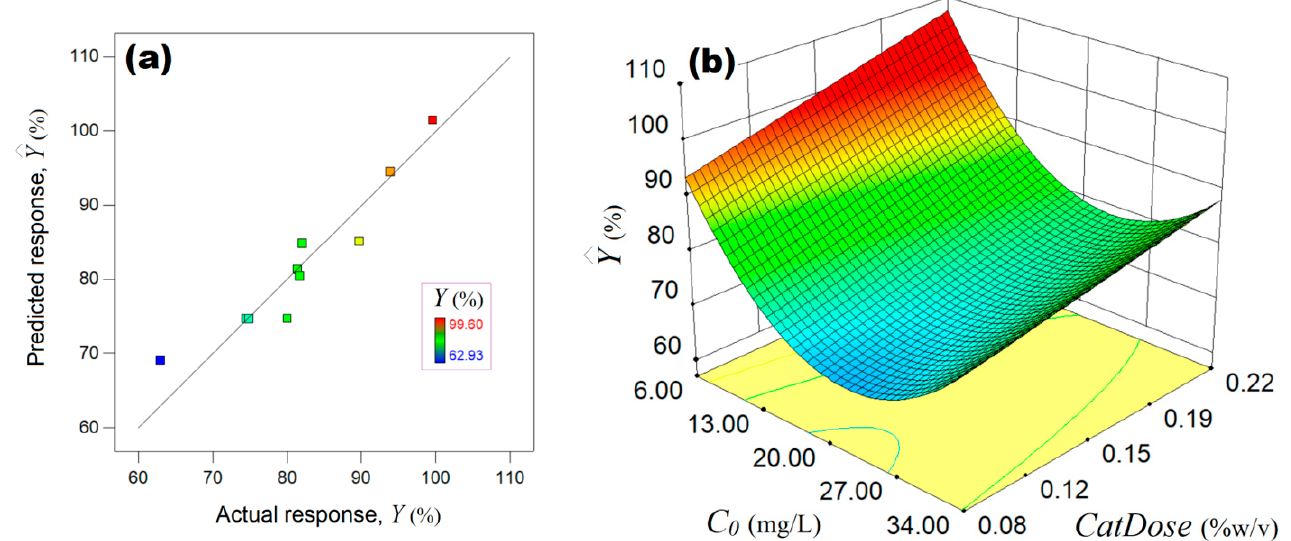
Figure 9. Outcomes of empirical modeling by RSM: ( a ) agreement between experimental observations and model estimations; ( b ) response surface plot predicted by the empirical model showing the synergistic influence of C 0 and CatDose factors on the estimated response ( ˆ Y ,%).